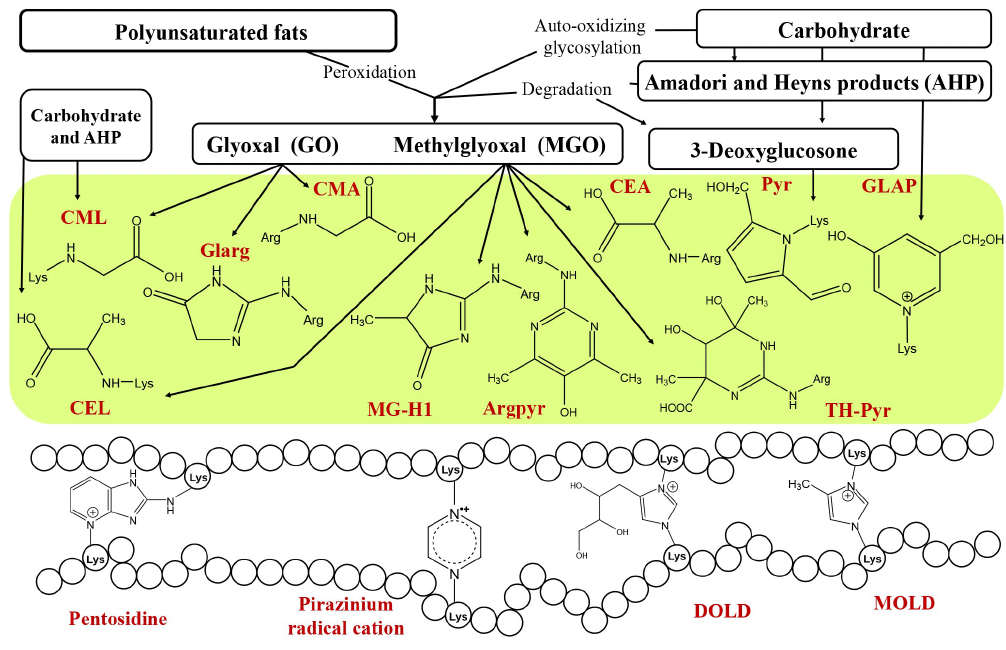
Figure 2. Advanced glycation end products (AGEs), their precursors and intermediates in the context of underlying formation mechanisms. Abbreviations: CML, N ε -(carboxymethyl)-lysine; CEL, N ε -(carboxyethyl)-lysine; CEA, N δ -(carboxyethyl)-arginine; CMA, N δ -(carboxymethyl)-arginine; Glarg, glyoxal-derived hydroimidazolone; MG-H1, methylglyoxal-derived hydroimidazolone ( N δ -(5-methyl-4-oxo-5-hydroimidazolinone-2-yl)- l -ornithine); Argpyr, argpyrimidine; TH-Pyr, tetrahydropyrimidine; Pyr, pyrraline; GLAP, glyceraldehyde derived pyridinium compound; MOLD, lysine-lysine imidazolium cross-link, derived from methylglyoxal; DOLD, lysine-lysine imidazolium cross-link derived from 3-deoxyglucosone.